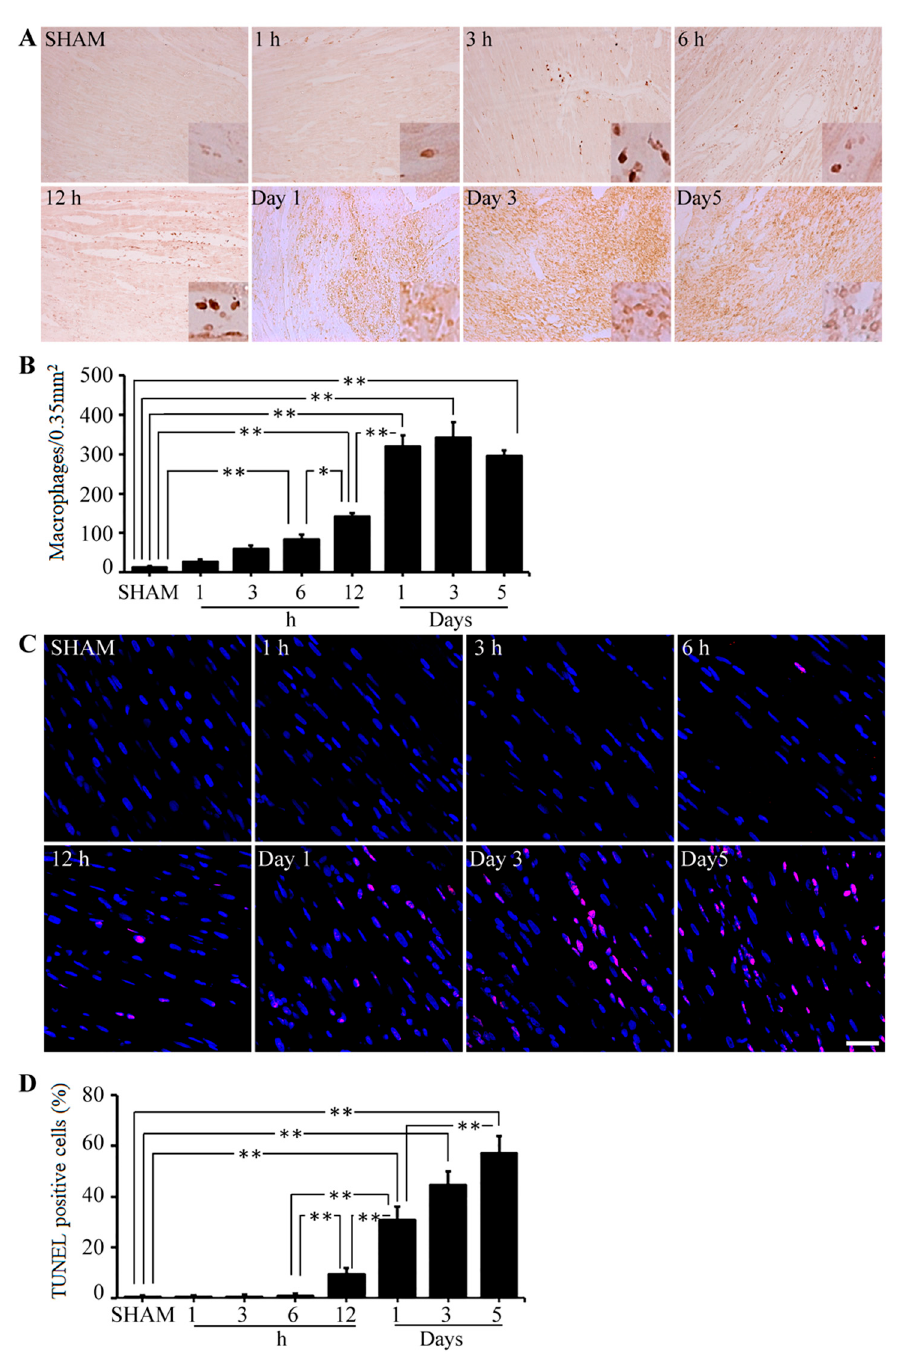
Figure 2. Time-dependent distribution of activated macrophages and apoptotic cardiomyocytes in the left ventricle of the sham and ischemic reperfusion injured heart of rats. ( A ) Iba-1-positive macrophage cells were measured by immunohistochemical staining in control or ischemic reperfusion injured rat hearts at different time periods. ( B ) A number of Iba-1-positive cells in the heart of control and ischemic reperfusion injured rats. ( C ) TUNEL staining used to detect apoptotic cardiomyocytes in control or ischemic reperfusion injured rat hearts at different time periods. ( D ) A percent of TUNEL-positive cells in the heart of control and ischemic reperfusion injured rats. Scale bar = 50 μ m. In the statistical analysis, a one-way ANOVA was performed, and Tukey’s test was used to compare means: *, p < 0.05; **, p < 0.01.